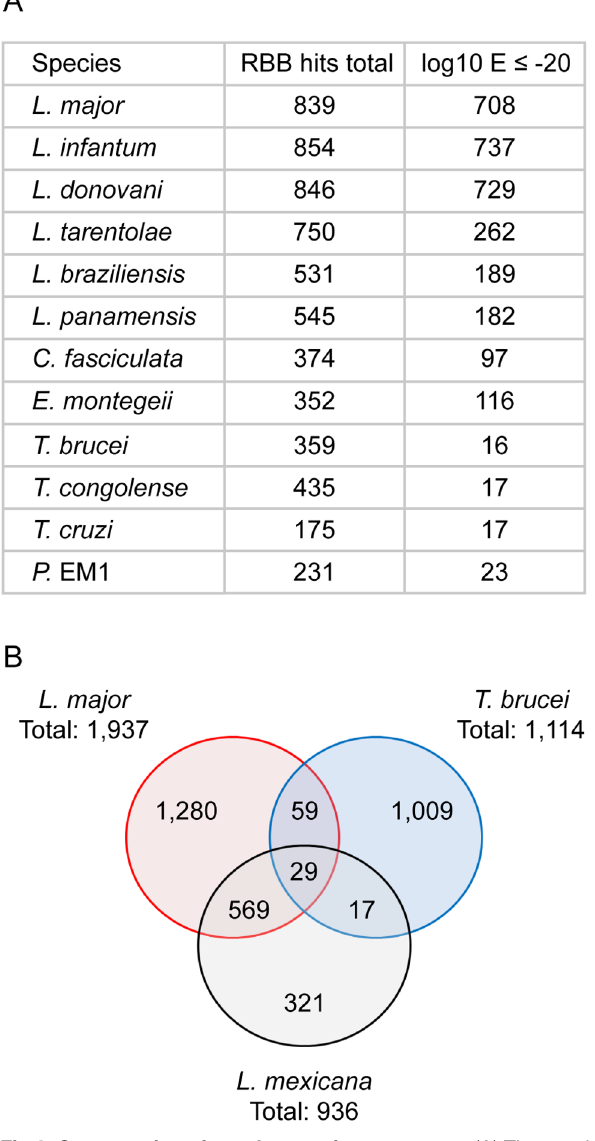
Fig 4. Conservation of novel transcript sequences. (A) The novel transcripts were used as query sequences in a reciprocal best tblastx search of 12 kinetoplastid genomes. “ RBB hits total ” indicates the number of reciprocal best tblastx hits returned; “ log10 E (cid:3) -20 ” indicates the number of hits returned with an E value (cid:3) 10 − 20 for the reciprocal tblastx search. (B) Venn diagram showing the number of hits returned in a series of reciprocal best tblastx searches comparing the novel transcripts found in L . mexicana (this study), L . major [30] and T . brucei [42]. intergenic control sequences. About one in five of the novel transcripts returned reciprocal tblastx hits with E values (cid:3) 10 − 20 across Leishmania Leishmania and Leishmania Viannia spp., but not in Trypanosoma spp.; these may represent bona fide conserved protein coding sequences specific to Leishmania spp. 19 novel transcript sequences returned strong reciprocal best tblastx hits with E values (cid:3) 10 − 20 from Leishmania spp ., Trypanosoma spp. and Phytomo- nas genomes (Figs 4A and 5C and S6 Table) indicating that the coding potential of these sequences is conserved in these genera. A separate reciprocal tblastx analysis comparing the